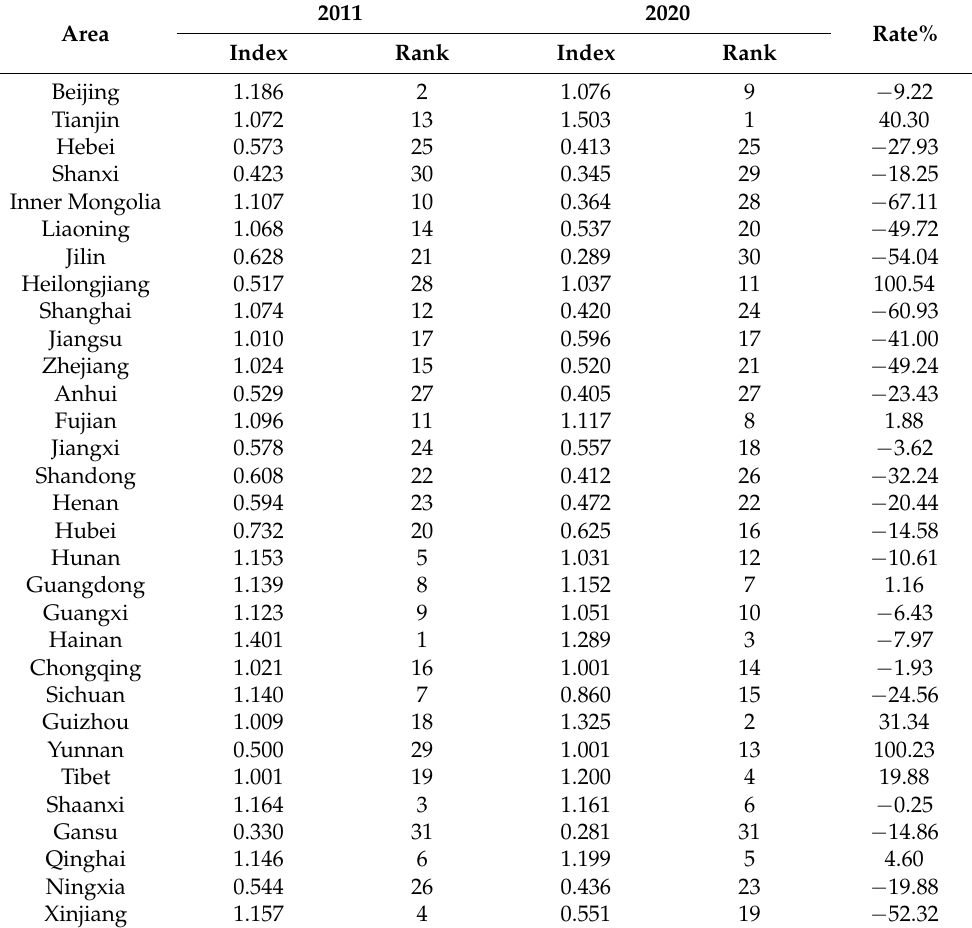
Table 5. Agricultural eco-efficiency and ranking of provinces in China.